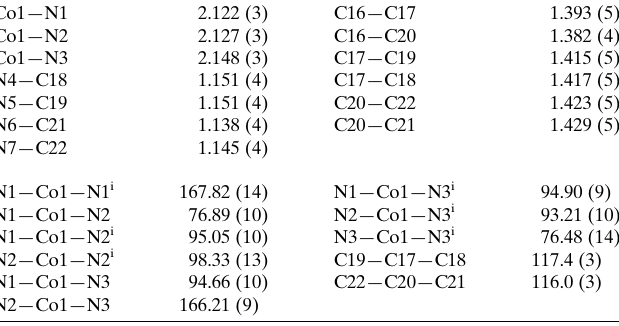
Table 1 Selected geometric parameters (A˚ , (cid:4) ).